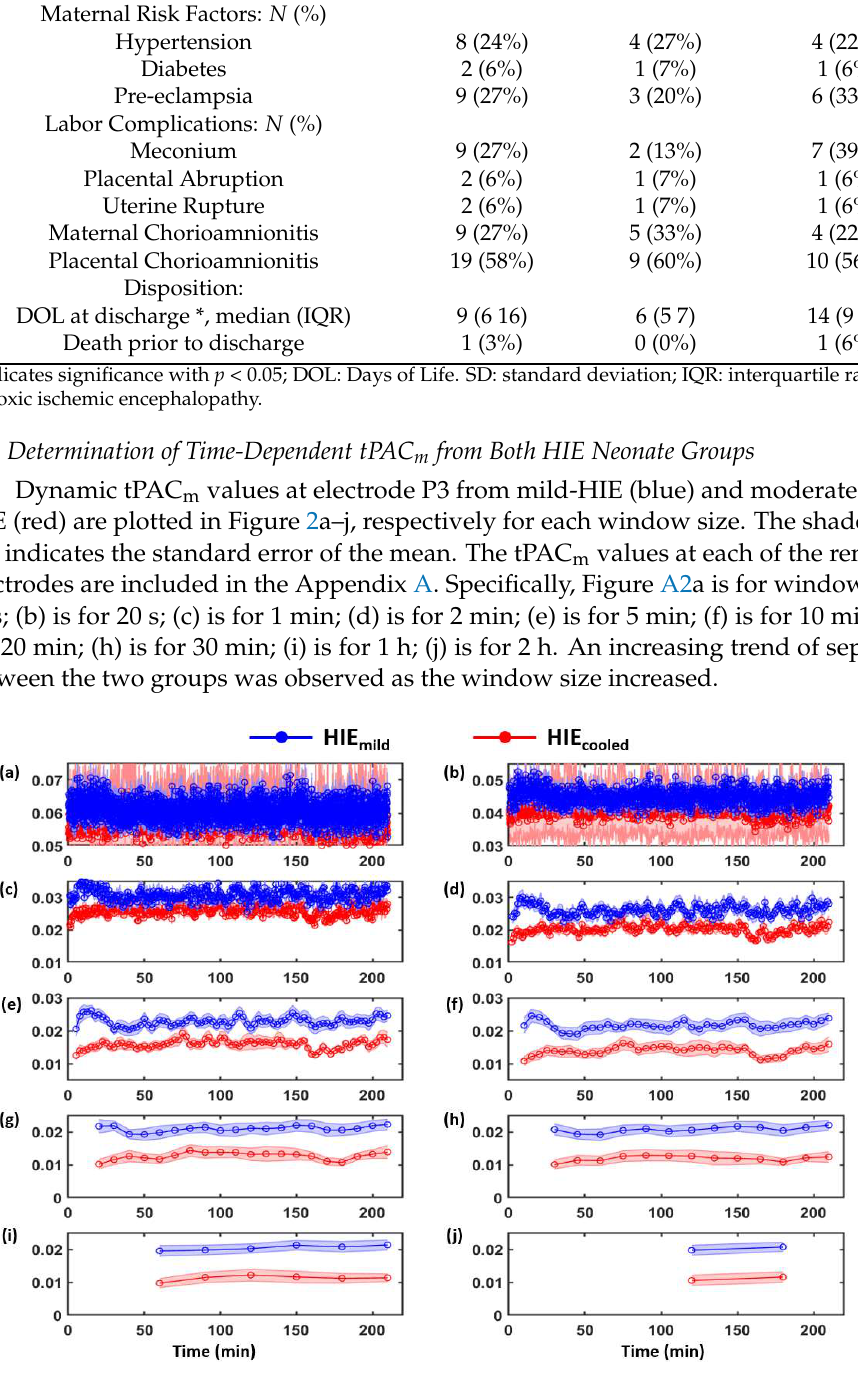
Figure 2. tPAC m indexes at P3 from 15 HIE mild (blue) and 18 HIE cooled (red) under ( a ) 10 s; ( b ) 20 s; ( c ) 1 min; ( d ) 2 min; ( e ) 5 min; ( f ) 10 min; ( g ) 20 min; ( h ) 30 min; ( i ) 60 min; ( j ) 120 min window sizes. Each point denotes the cross-neonate average of tPAC m for the group at different times. The shaded error bar indicates the standard error of the mean. t = 0 indicates the start of EEG recording. HIE infants meeting cooling criteria are shown in red. Infants with mild or no encephalopathy by hospital discharge are shown in blue. HIE: Hypoxic Ischemic